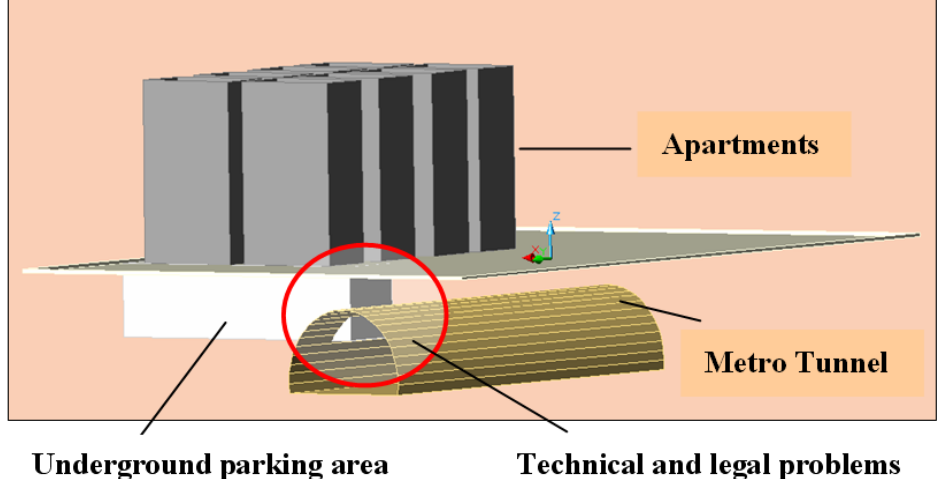
Figure 7. Apartments with underground parking lot